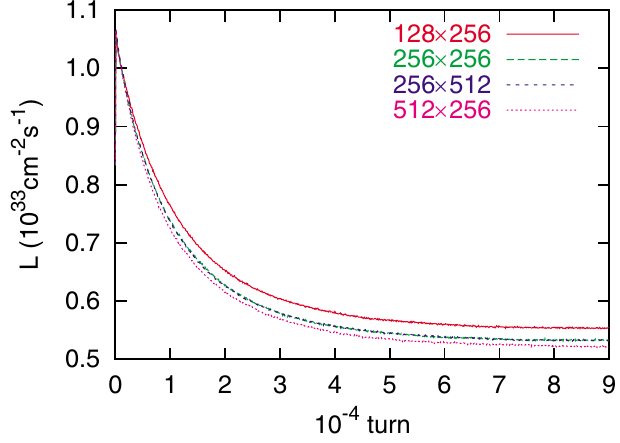
FIG. 6. (Color) Evolution of simulated luminosity for various grid